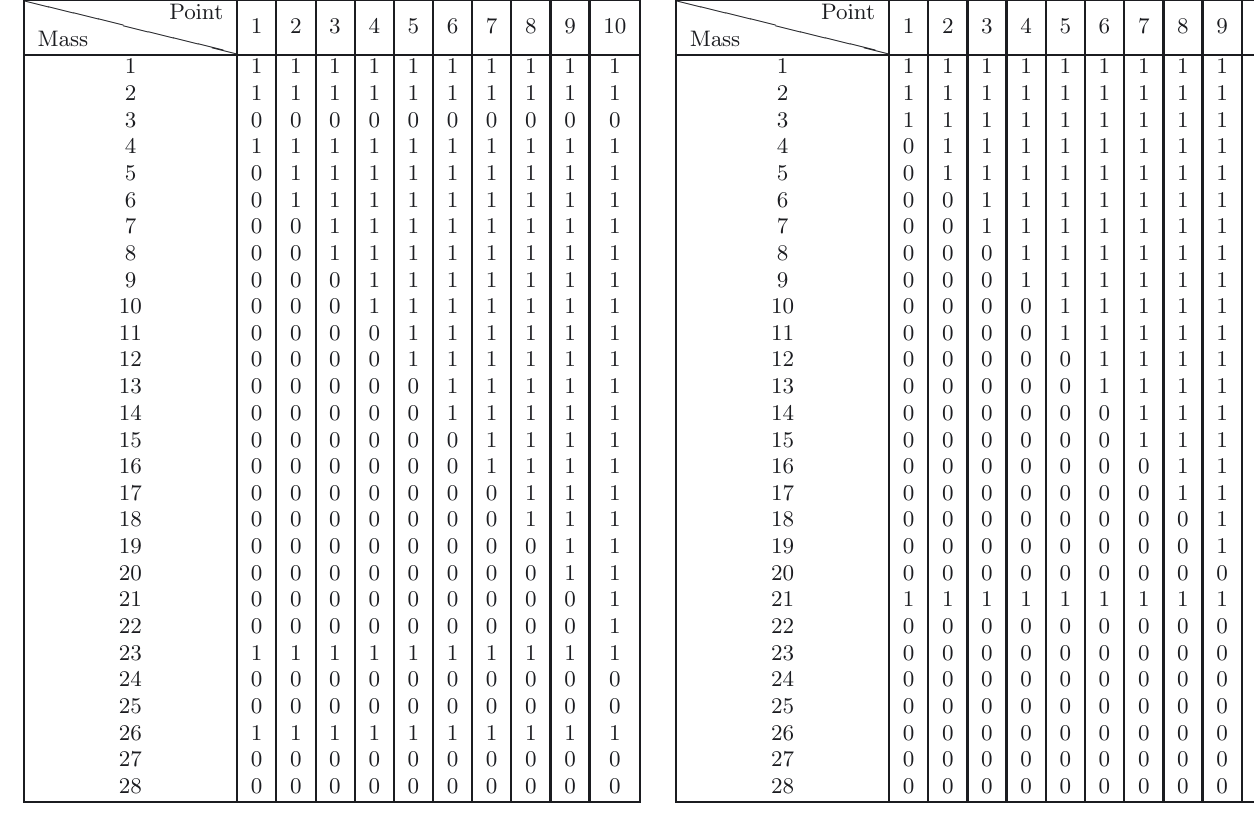
Table 3. Boolean values of utilized laboratory standard mass pieces used for generated pressures where mass piece #1 and mass piece #2 correspond to the piston and bell masses respec- tively, and points 1 through 10 correspond to the cross-floated pressures from 50 MPa to 500 MPa respectively.